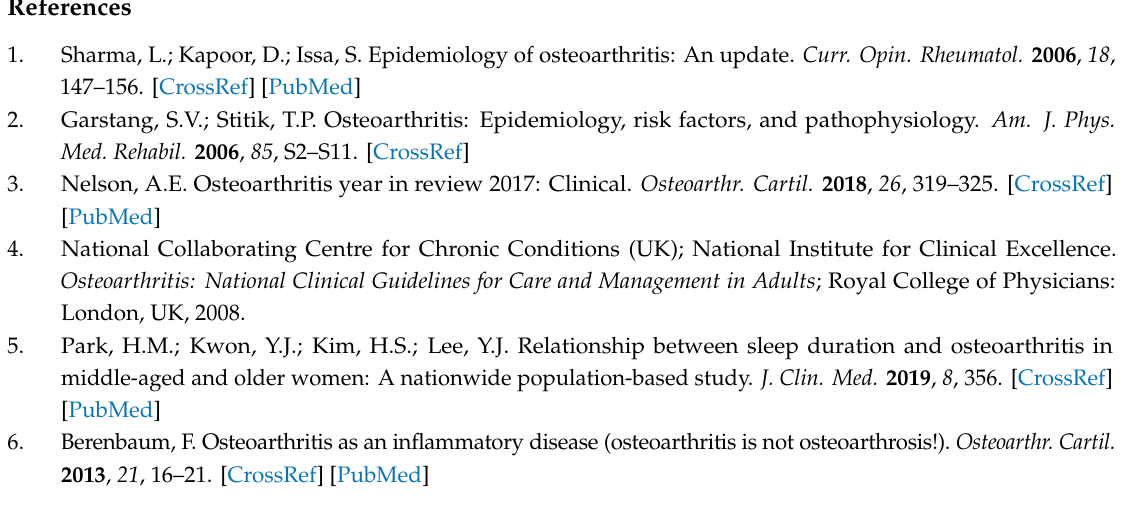
Figure S1: Percentage of Participants with Weight Status According to the Severity of Osteoarthritis, Figure S2: Mean Value of BMI According to the Severity of